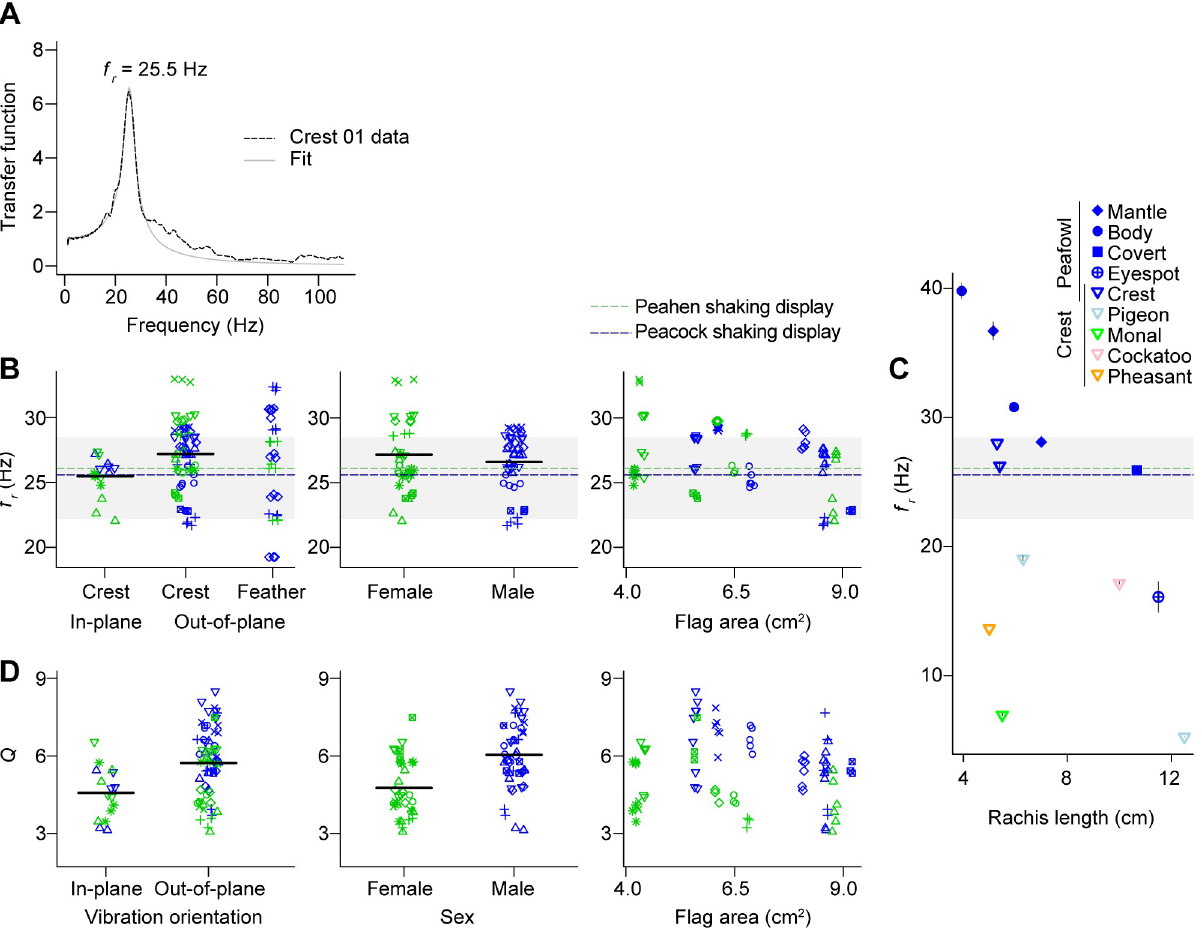
Fig 3. Vibrational resonance properties of peafowl crests and individual crest feathers. (A) Vibrational spectrum and Lorentzian fit for peacock crest sample Crest 01. (B-D) Data on the mean crest resonant frequencies, f r , and quality factors, Q . Each dried crest sample (n = 8 female, n = 7 male) is indicated by a unique symbol-color combination, consistent with Fig 2. (B) The mean resonant frequencies, f , of the crest are a close match for the r range of vibrational frequencies used during peafowl social displays. As an indication of measurement error, the average 95% CI for each mean f r estimate spans 0.072 Hz. The gray shaded area is the range of vibrational frequencies of the train-rattling display, with dotted lines showing the means for displays performed by peacocks (blue) and peahens (green) [20]. Variation in f r was influenced by the vibrational orientation and was also associated with the sex of the bird, but there was no significant association with the area of pennaceous flags at the top of the crest. The first panel in (B) also shows how a small sample of single crest feathers (n = 3 from male Crest 03, n = 5 from male Crest 05, and n = 3 from female Crest 10) had a similar range of resonant frequencies as the whole crests vibrated in the same out-of-plane orientation. (C) Fundamental frequency for vibrations in the out-of-plane orientation for peafowl crest and non-crest feathers with similar lengths and crest feathers from four non-peafowl species described in S1 Table and S1 Fig. Means for male and female peafowl crests are both plotted. The y-axis of (C) is aligned with that of (B) for comparison. (D) The mean quality factor, Q , was also influenced by the vibrational orientation, and was associated with the sex of the bird and the area of pennaceous flags. The average 95% CI for each mean Q estimate spanned 0.233. Black horizontal lines in (B) and (D) are grand